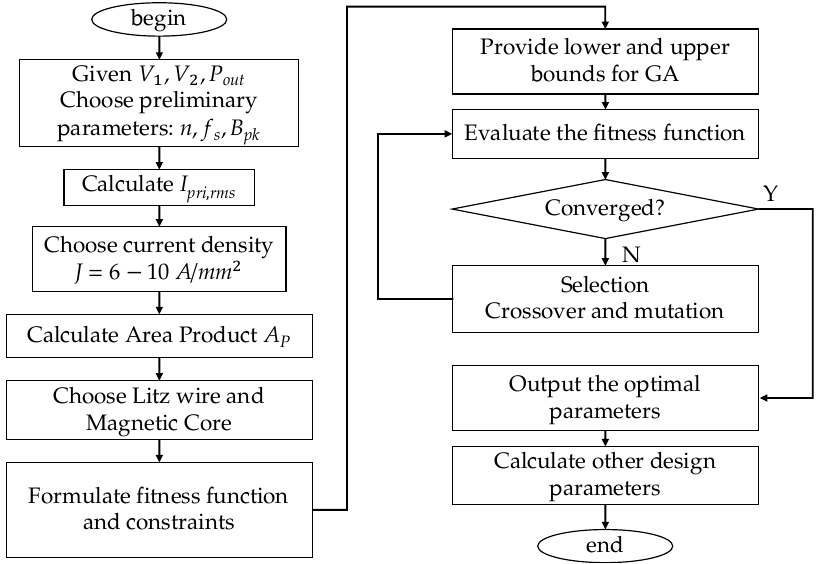
Figure 5. Design and optimization flow